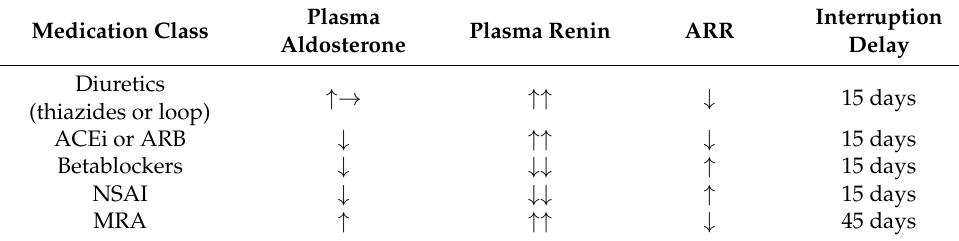
Table 1. Effect of medications on plasma renin and